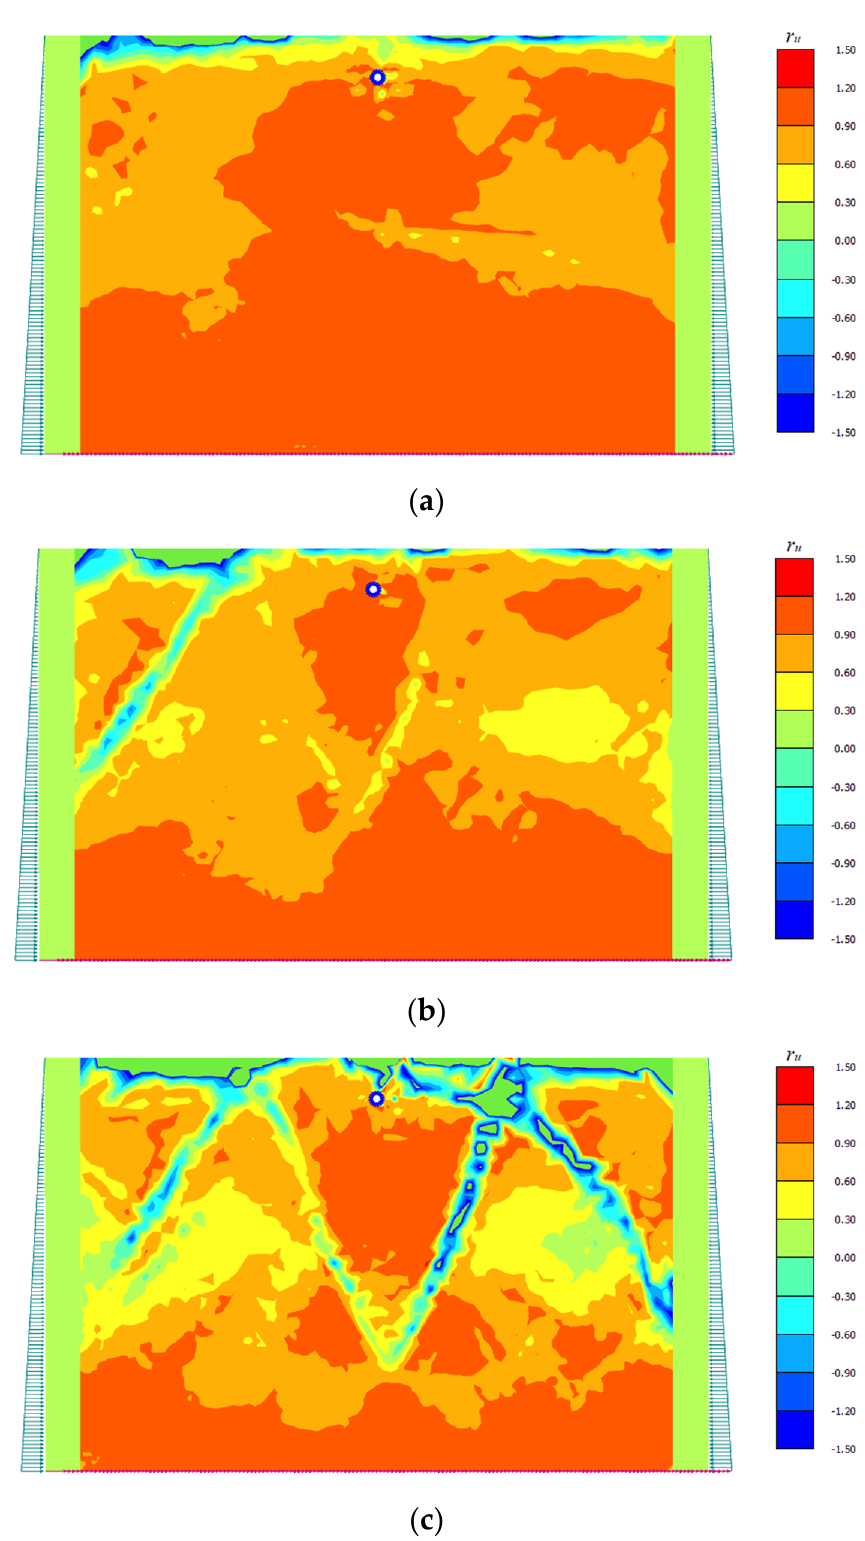
Figure 5. Liquefaction potential of soil with 50% relative density and a seismic signal of 1 Hz frequency and ( a ) 0.1 g, ( b ) 0.3 g, and ( c ) 0.5 g amplitudes.